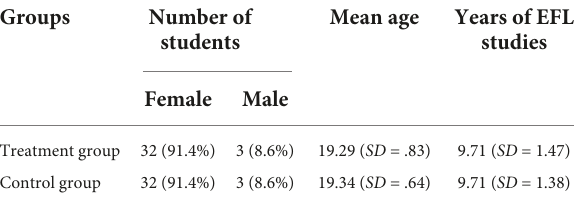
TABLE 1 Demographic information of the treatment and control groups. Groups